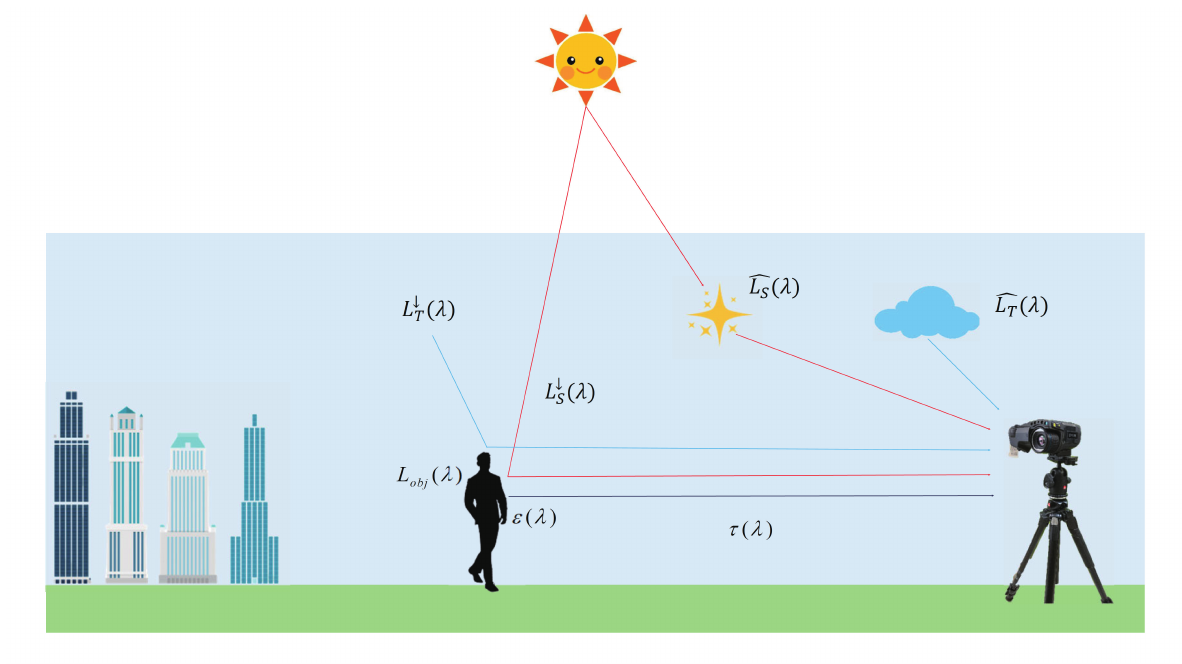
Figure 1. Principle of the radiation measured by a long-wave infrared camera that intuitively shows Equation